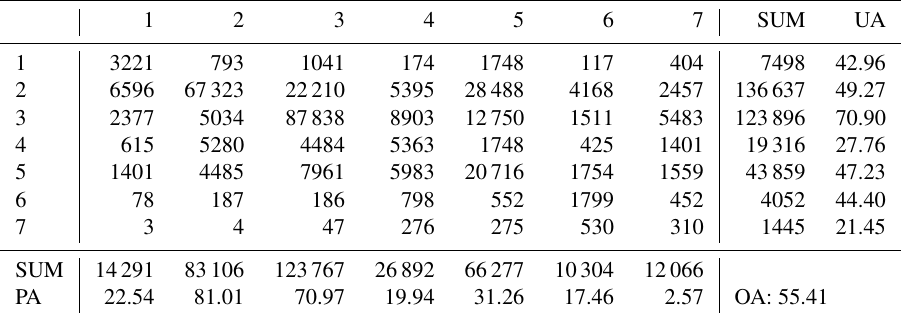
Table B3. Confusion matrix for LANDMATE PFT group 0.3 – the dominant LULC type occupies a minimum of 30% of a LANDMATE PFT grid